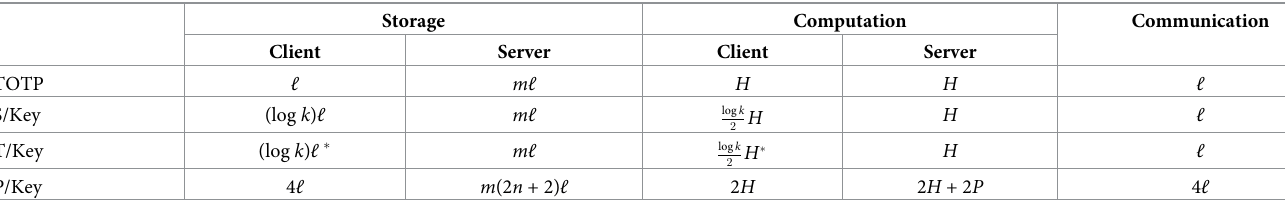
Table 2. Storage, computation, and communication costs of various